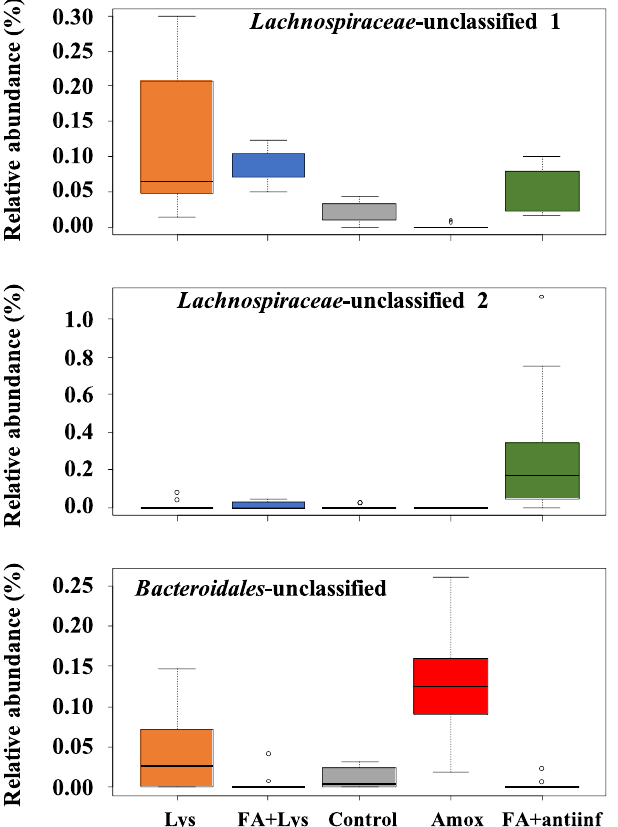
Figure 9. Analysis of composition of microbiomes (ANCOM) on nasal microbiota comparing groups after treatment (D21). The ANCOM at amplicon sequence variant (ASV) level detected two unclassified members from Lachnospiraceae family and one member from Bacteroidales order as differentially abundant. The mean relative abundance of these ASVs is shown in percentage. Each boxplot corresponds to one treatment group: Lys lysozyme, FA + lys medium chain fatty acids and lysozyme, C control, with no additives, Amox amoxicillin, FA + antiinf medium chain fatty acids and a natural antiinflammatory. The dotted lines represent standard deviation and outliers are indicated with white